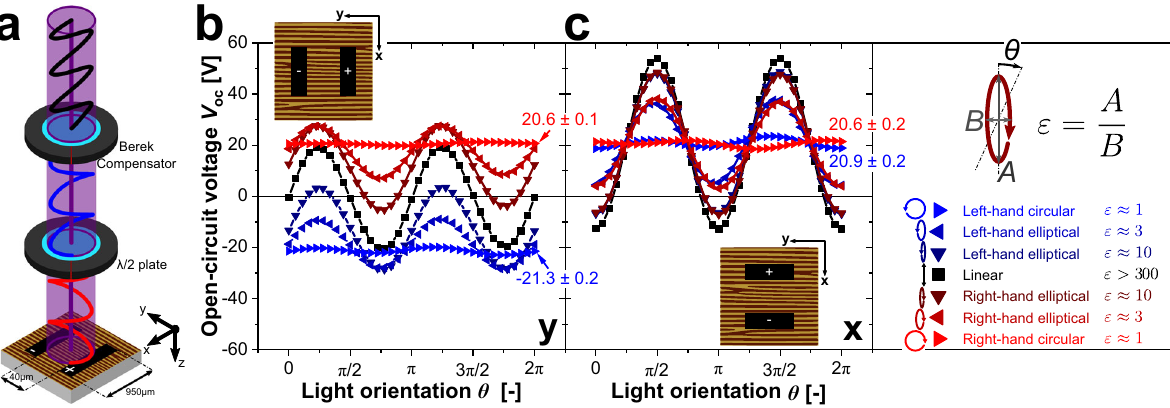
Fig. 3 Deconvolution of the BPV response into linear and circular effects. a Schematic of the extended setup (not to scale) comprising a Berek compensator (tunable waveplate) to set arbitrary polarization state of the light ε with a subsequent λ by θ . V oc as a function of the light polarization orientation θ for different light polarization states measured in b y-direction and c x-direction. Right- and left- handedness of light is colored red and blue, respectively. The light polarization state as varied from linear ( ε > 300) over two elliptical ( ε ≈ 10, ε ≈ 3) to circular ( ε ≈ 1) light